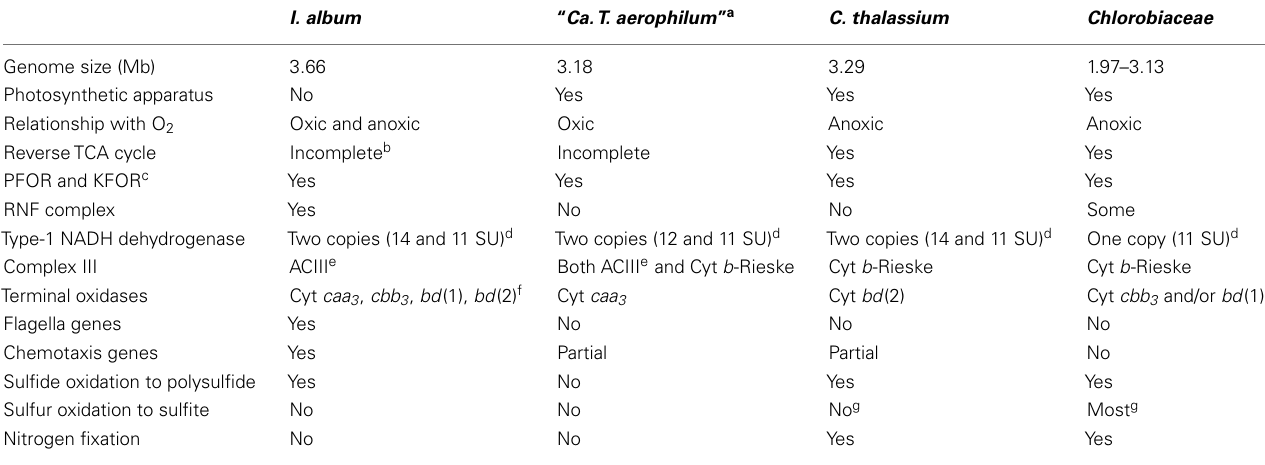
Table 1 | Summary of distribution of major properties for organisms belonging to the phylum